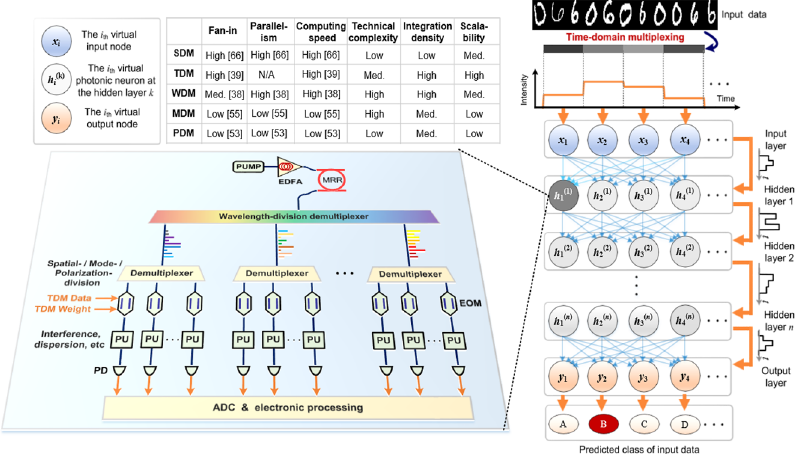
Figure 9: Schematic of a photonic neuron using hybrid multiplexing techniques. EOM, electro–optical modulation; PU, processing unit; PD, photodetector; ADC, analog-to-digital